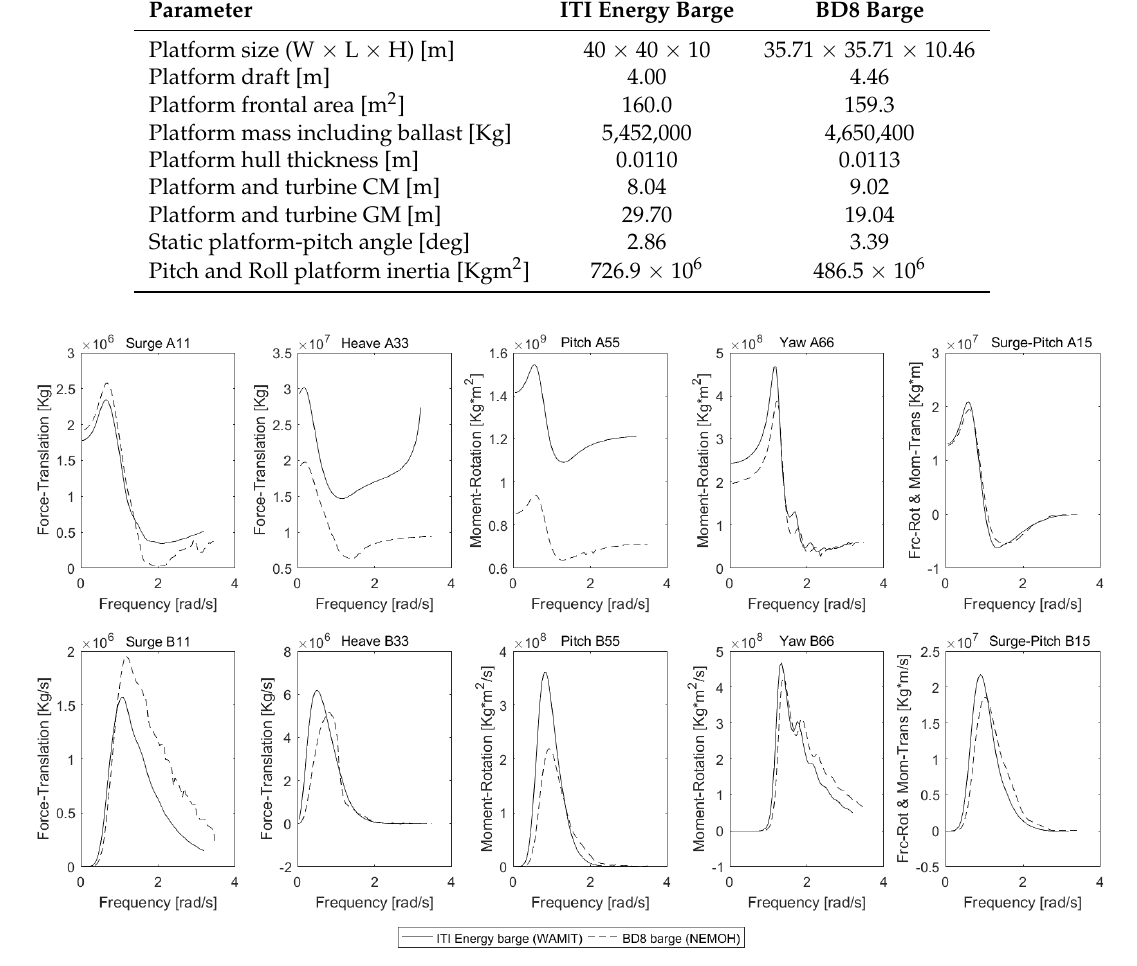
Figure 2. ITI Energy and BD8 barges hydrodynamic